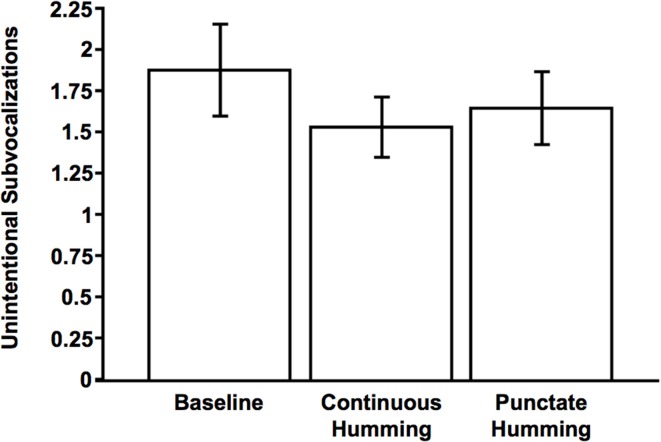
Mean number of unintentional subvocalizations as a function of condition (Baseline, Continuous Hum, Punctate Hum). Error bars indicate 95% confidence interval.